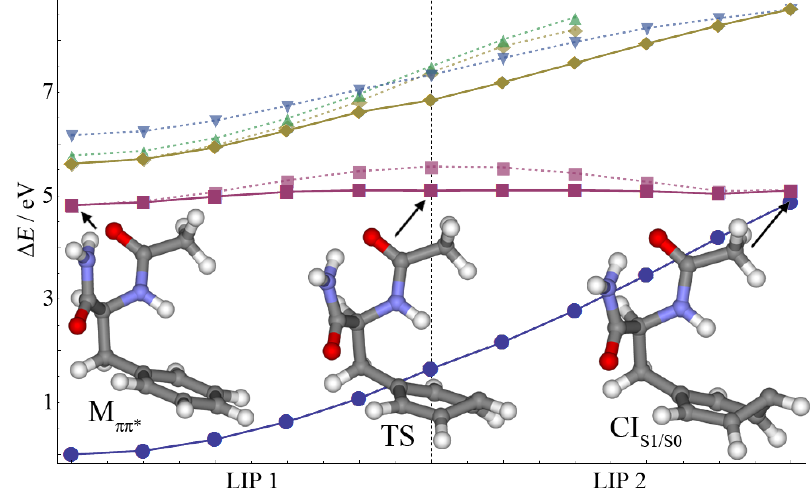
Figure 10. Energy profiles of the two lowest excited states and the electronic ground state for phenyl ring-puckering at the para C atom position in NAPA B. The insets show the M ππ ∗ minimum, the S 1 transition state (TS) and the S 1 /S 0 CI structure. The TS structure was obtained by reoptimizing the starting maximum energy geometry taken from the initial LIP between M ππ ∗ and CI geometry (bordeaux dashed line). Two separate LIPs between M ππ ∗ minimum and the TS (LIP1) and between TS and CI (LIP2) are fused to obtain the full reaction